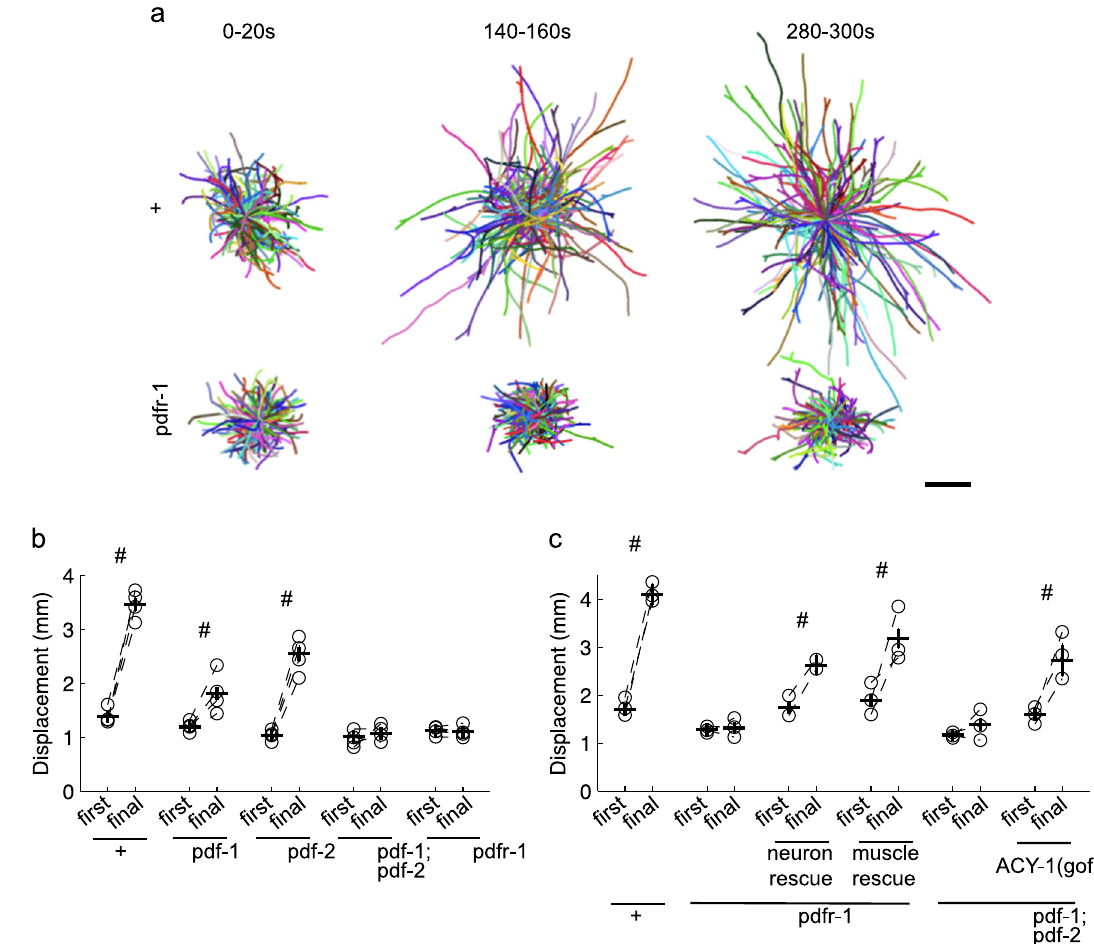
Fig. 5 PDF signaling promotes dispersal during habituation training. a Representative trajectories during a 20 s interval at the beginning (0 – 20 s), middle (140 – 160 s), and end (280 – 300 s) of the habituation assay with thirty 2 s light pulses delivered at 0.1 Hz. Individual tracks were randomly assigned colors and set to start from the same point. N = 4 plates/strain. Scale bar = 1 mm b Displacement (shortest distance between the start and endpoint) over the fi rst and fi nal 30 s of the assay for the PDF signaling mutants. c Displacement over the fi rst and fi nal 30 s of the assay for PDF signaling mutant rescue lines. ‘ # ’ denotes a signi fi cant increase in displacement (one-tailed, P < 0.01, with Bonferroni correction for multiple comparisons) over the assay. Circles are plate means, crosses are population means ±